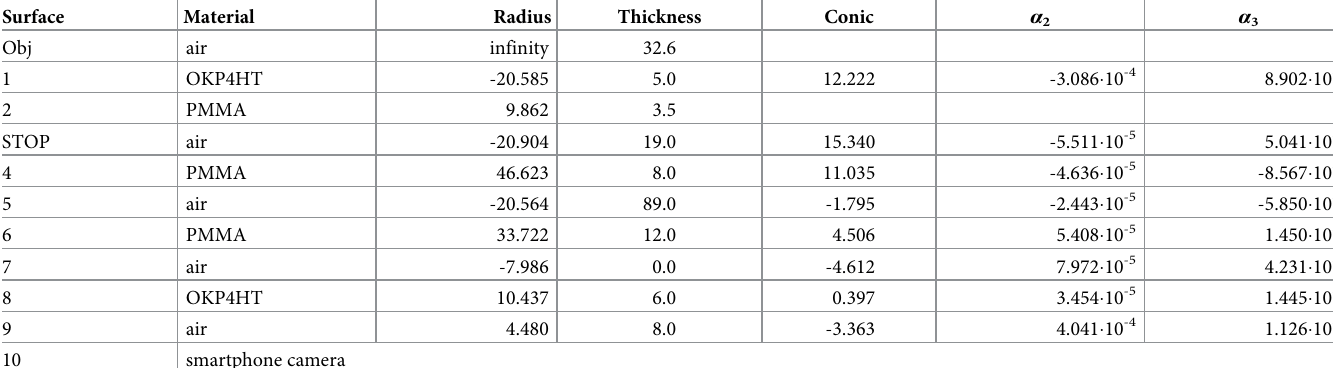
Table 1. Intraoral probe optical system